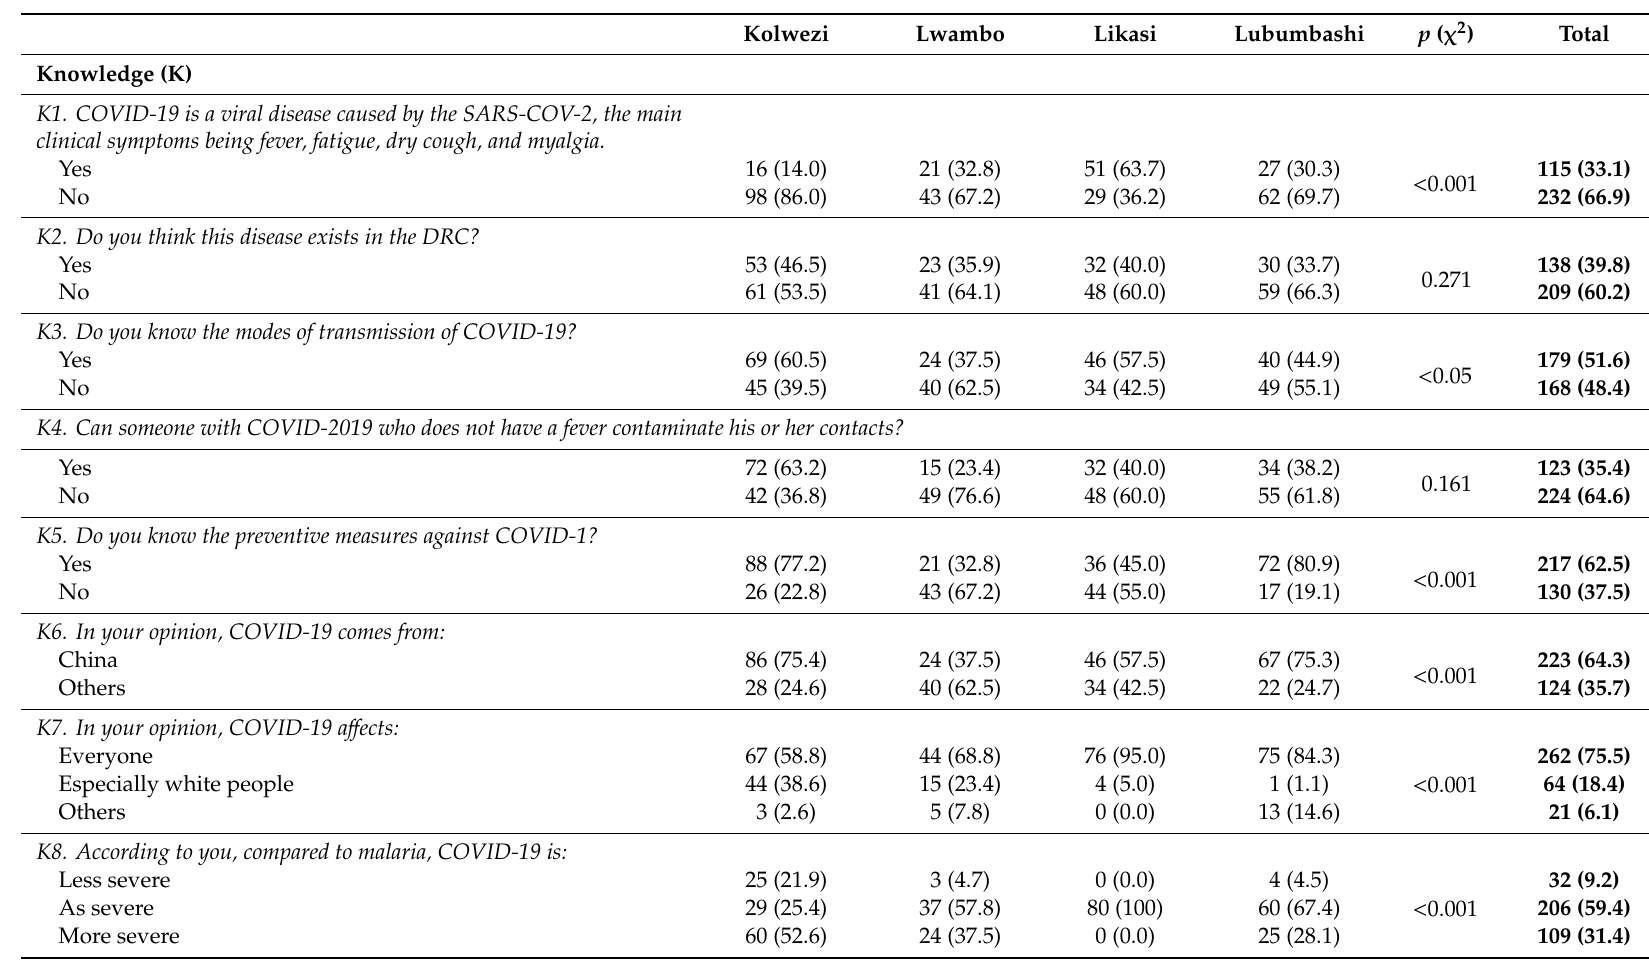
Table 2. Responses of participants to questionnaire surveys done between 16 and 29 April 2020 on ten markets in four locations of the former Katanga province of DR